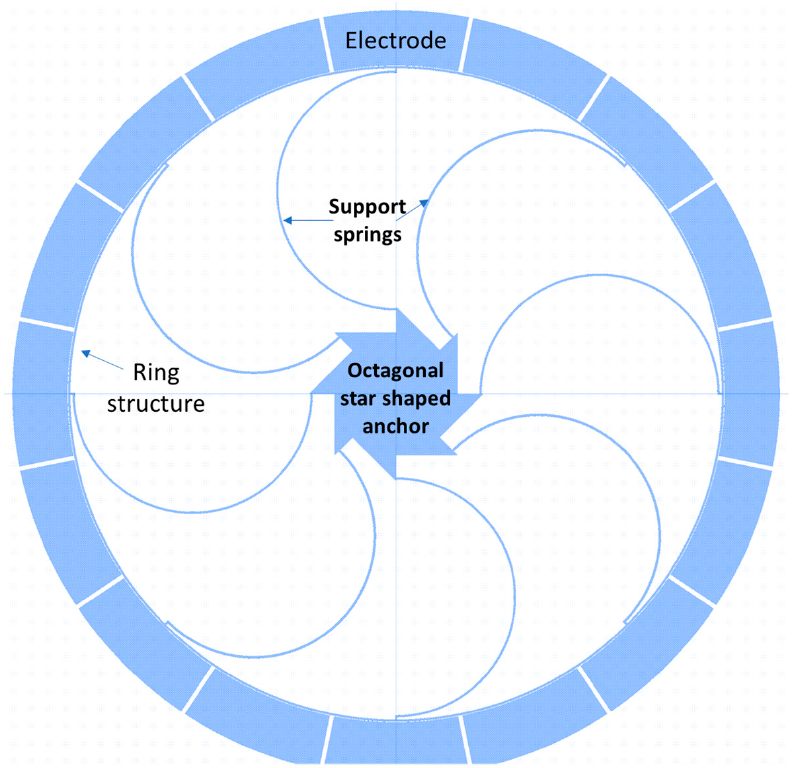
Figure 22. Schematic diagram of an octagonal star-shaped vibrating ring gyroscope.